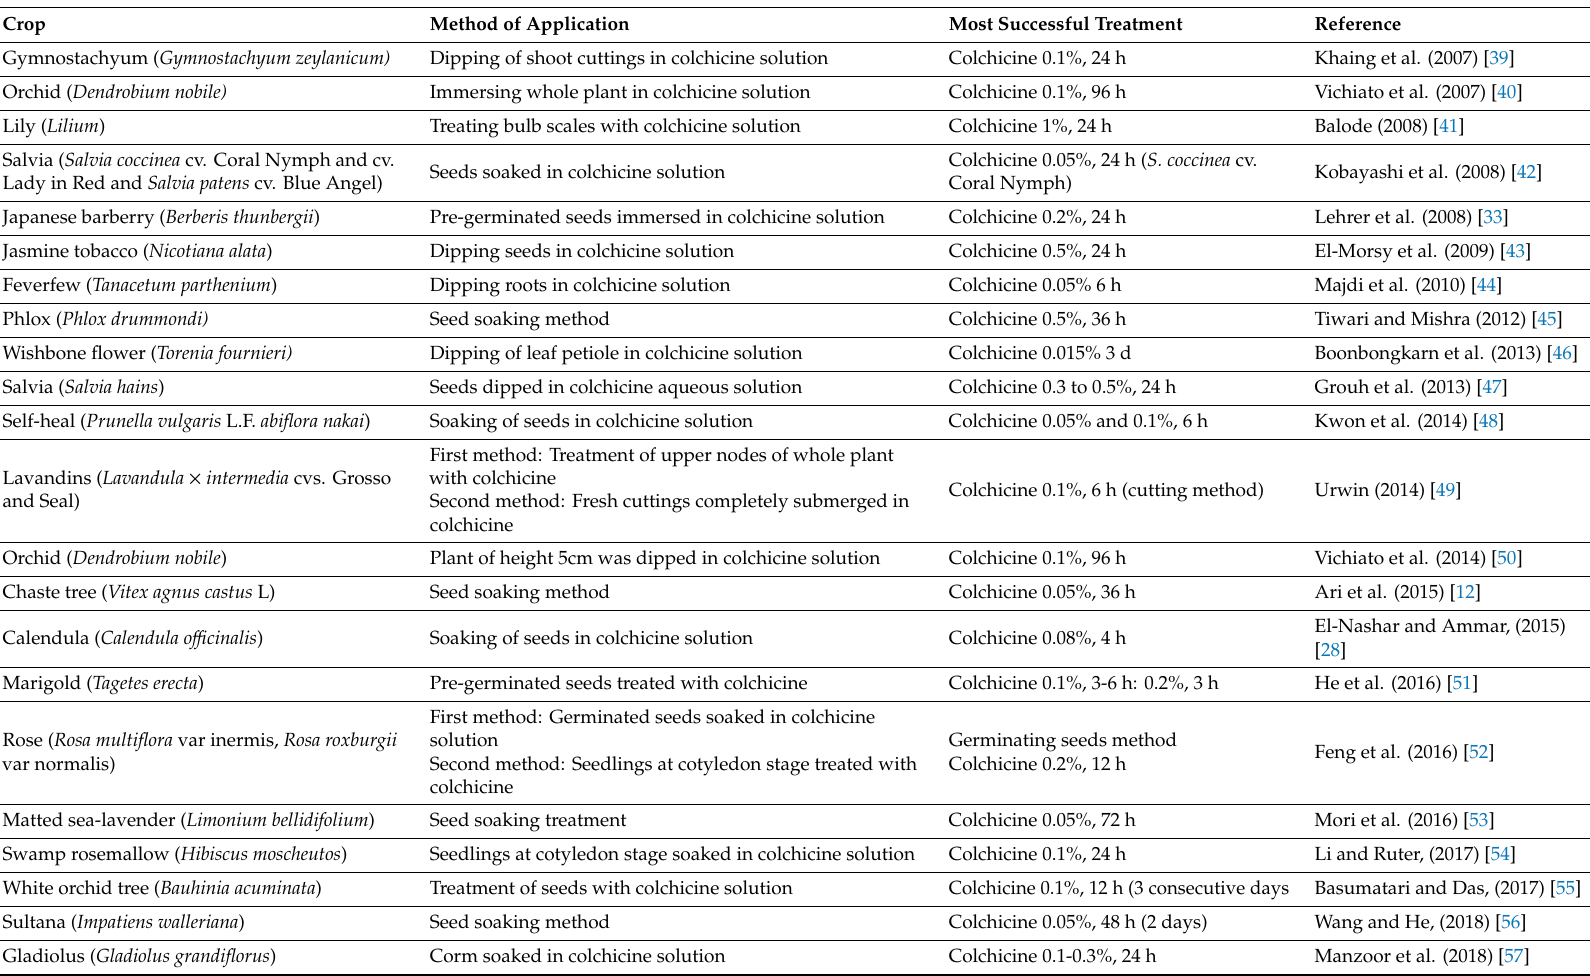
Table 1. Induction of polyploidy in ornamental plants by applying colchicine through dipping method since last fifteen